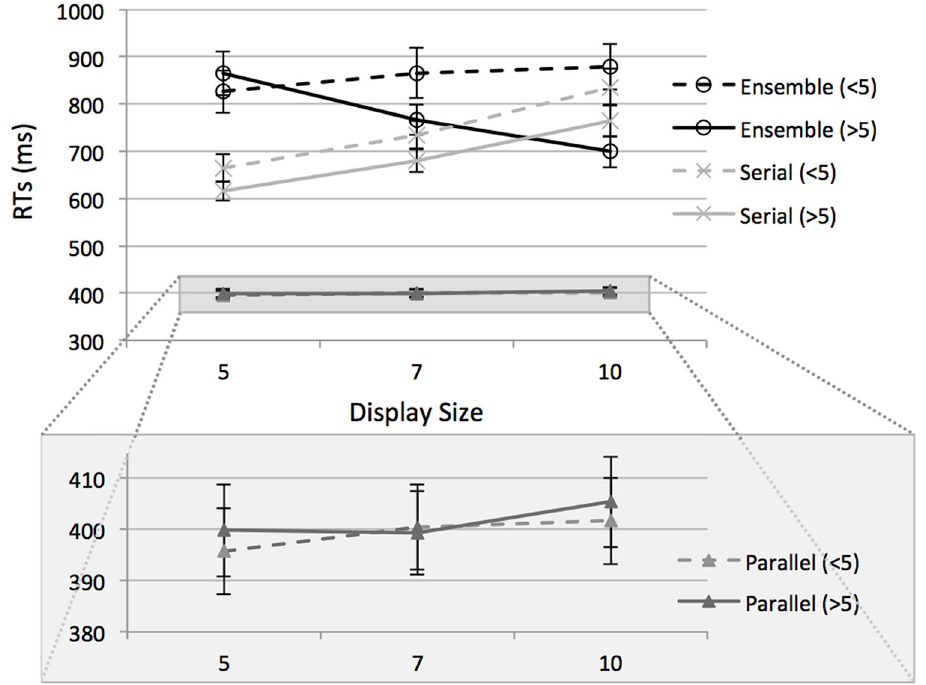
Figure 4. RTs for the serial search (light gray), parallel search (dark gray), and ensemble task (black) in Experiment 1 plotted as a function of display size and separated by target type. Note. Dashed lines indicate < 5 and solid lines indicate > 5. Error bars represent standard error of the mean. RTs increased substantially with display size in the serial search task, but only slightly for parallel search (magnified in subfigure). RTs for the ensemble task decreased with larger displays in the greater-than-five condition (black solid